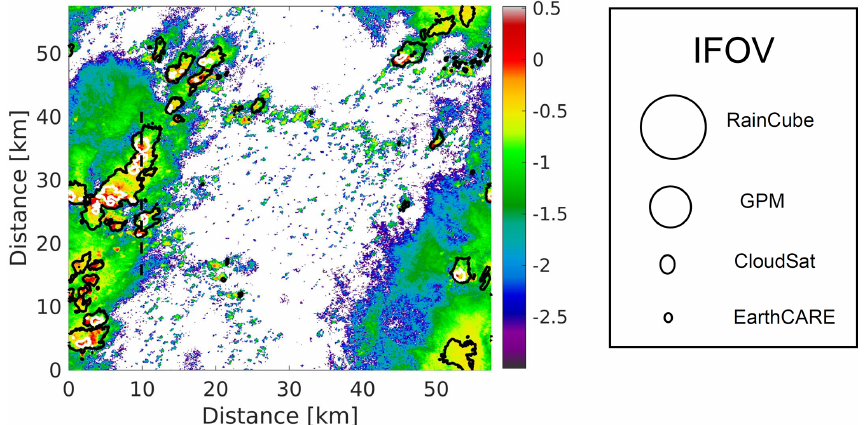
(cid:16) (cid:16) (cid:17) log 10 LWP [ kgm − 2 ] with contour lines of 10 and 500gm − 2